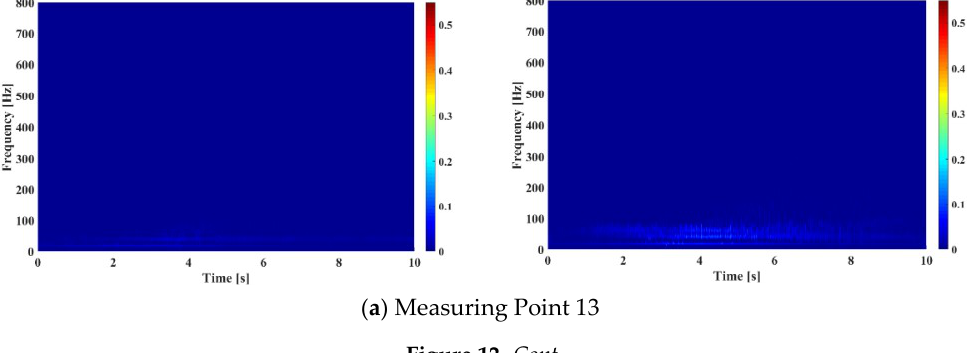
( a ) Measuring Point 13 Figure 12.